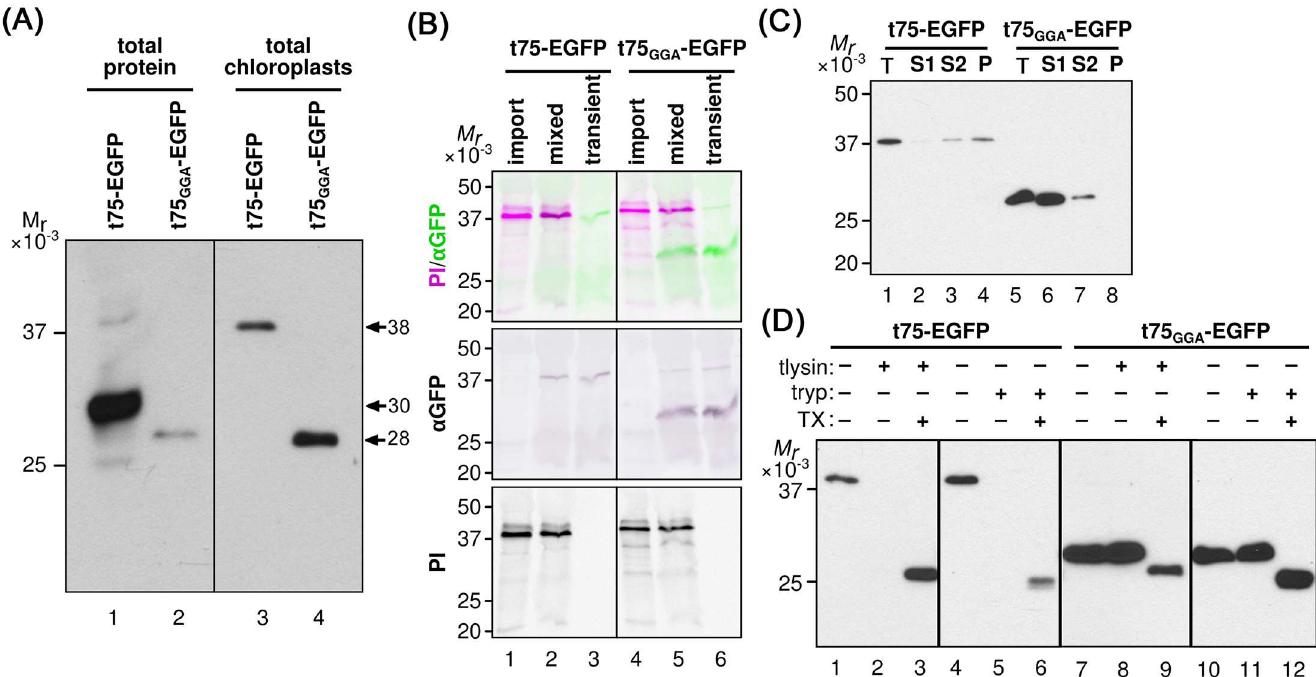
Fig 5. Biochemical analysis of t75-EGFP variants after transient expression in N . benthamiana . (A) Total protein extracts equivalentto ca . 12.5 mg fresh weight and total chloroplasts containing 10 μ g chlorophyllpreparedfrom leaves expressingt75-EGFP or t75 GGA -EGFP were separated by SDS-PAGE and analyzedby immunoblotting with the anti-GFP antibody. The bands corresponding to proteins of 38 kD, 30 kD, and 28 kD are indicated. Different regions from the same membraneare separatedby a black line. (B) Total chloroplasts after import (import) as in Fig 3A, total chloroplasts from agroinfiltrated leaves (transient) as in panel (A), and a mixture of them were separatedby SDS-PAGE and detected by immunoblotting with the anti-GFP antisera( α GFP) and phosphorimaging (PI). The combinedimage is false-colored green for α GFP and magentafor PI. Different regions from the same membraneare separated by black lines. Import samples were loadedat 2 μ g chlorophyll equivalentsand transient expressionsamples were loadedat 10 μ g chlorophyll equivalents. (C) Ten μ g chlorophyll equivalent total chloroplasts (T) isolatedfrom N . benthamiana leaves expressingt75-EGFP or t75 GGA -EGFP as well as S1, S2, and P fractions as preparedin Fig 2A were separatedby SDS-PAGE and proteins were detected by immunoblotting with the antisera againstGFP. (D) Intact chloroplastsisolated from N . benthamiana leaves expressingt75-EGFP or t75 GGA -EGFP were incubatedwith thermolysin (tlysin) or trypsin (tryp) with or without the presenceof Triton X-100 (TX) as describedin the legendto Fig 2B. Loading and detection were performed as in panel